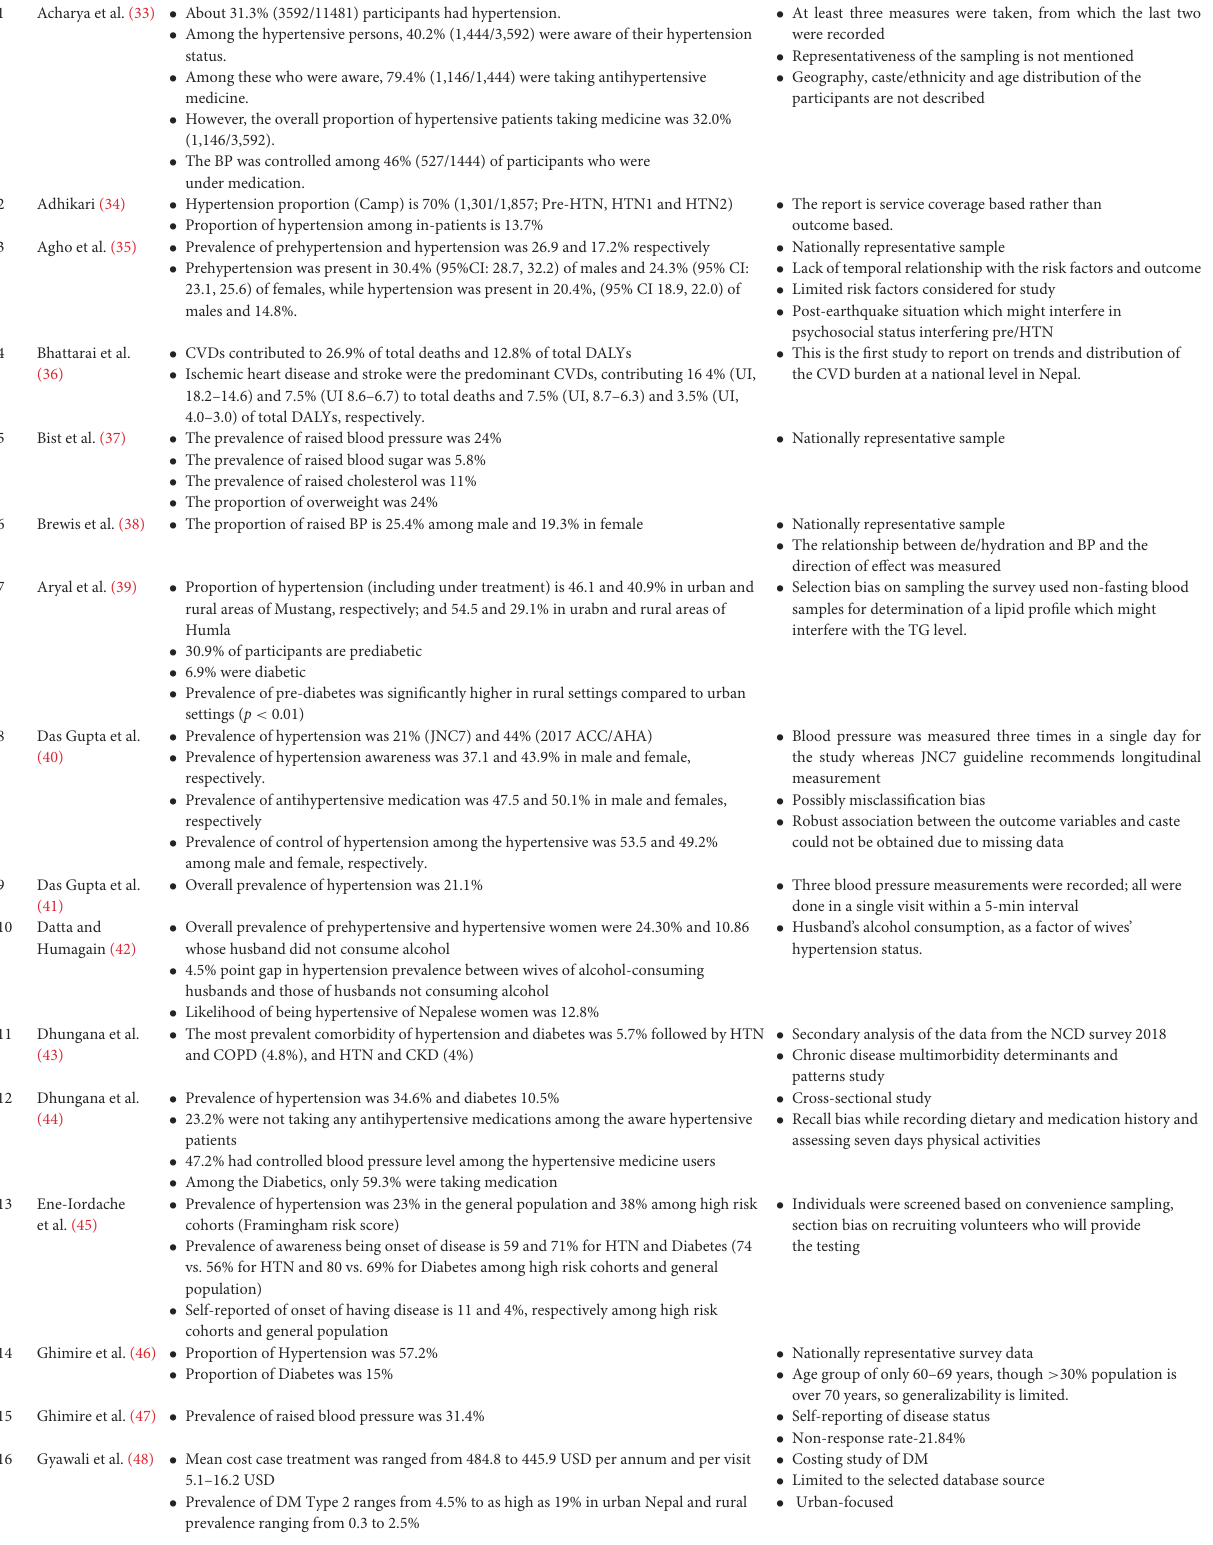
TABLE 3 Key findings, strengths, and limitations of included